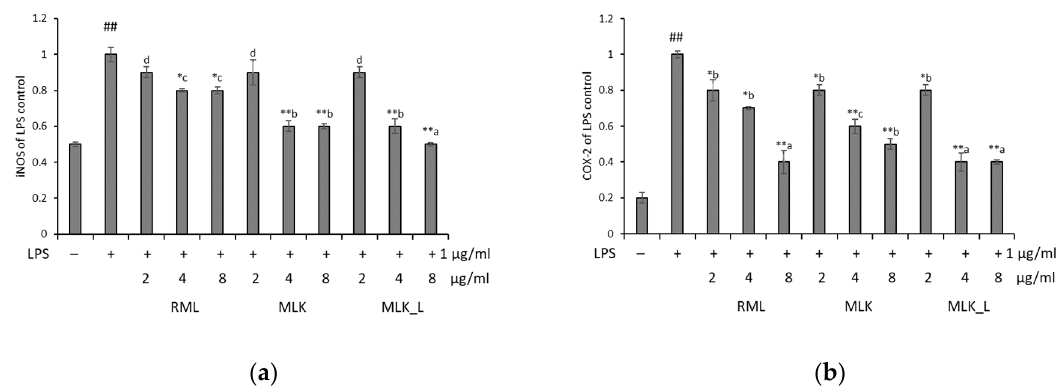
Figure 4. Effect of mustard leaves on the expression of related genes in LPS-induced RAW264.7 cells. The expression of ( a ) iNOS and ( b ) COX-2 by RT-PCR. Data were presented as the mean ± standard deviation (SD) of three independent experiments. Means sharing the same alphabet in superscript within each sample are not significantly different at p < 0.05 by ANOVA and Duncan’s multiple range test. * p < 0.05, ** p < 0.01 vs. LPS, and # p < 0.05, ## p < 0.01 vs. the LPS-stimulated group.